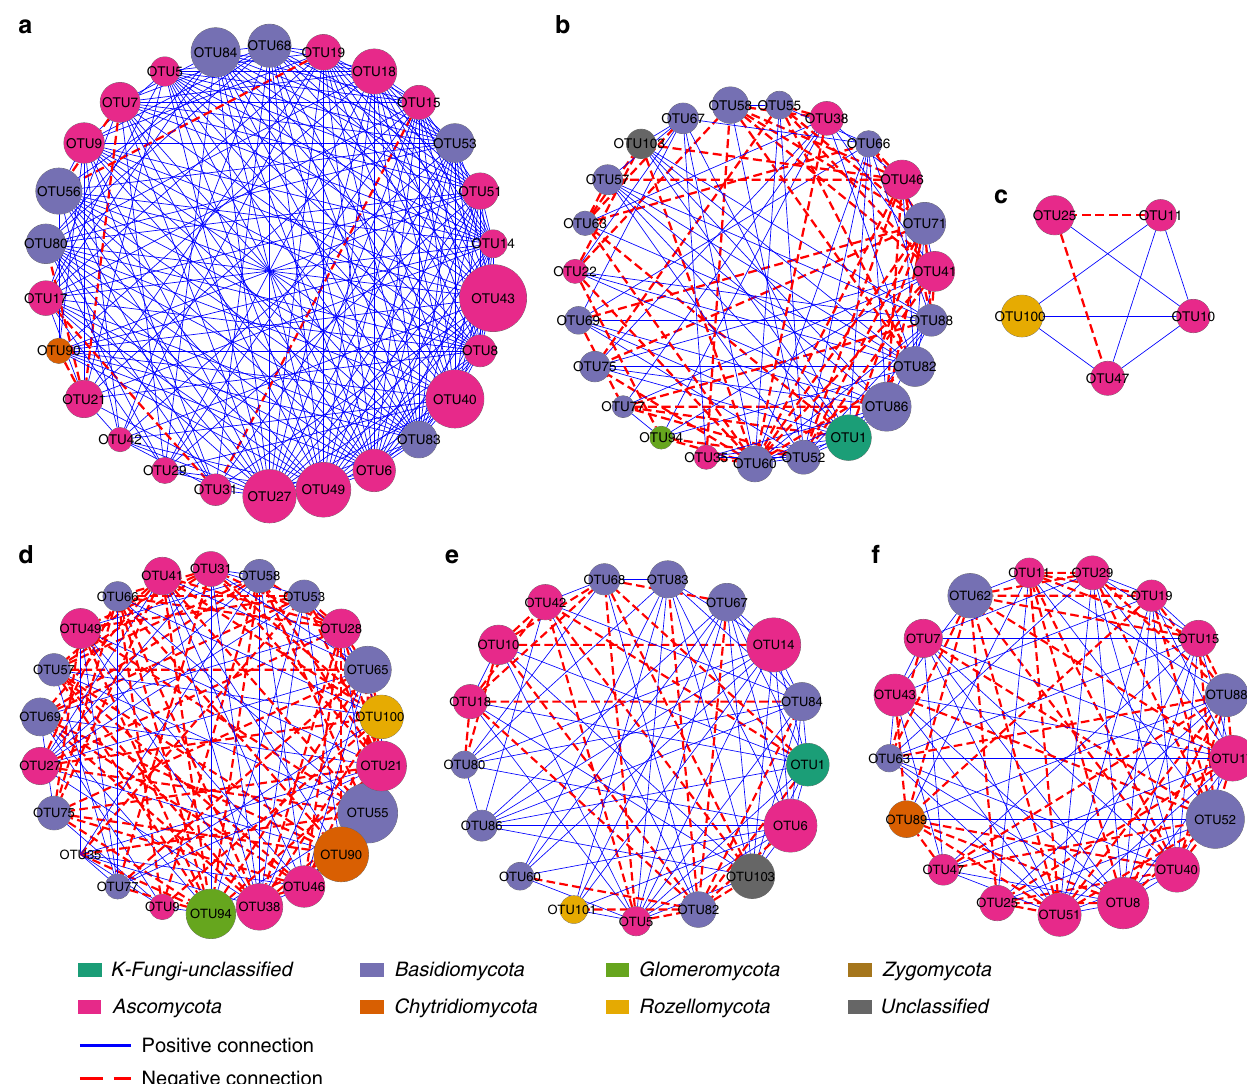
Fig. 6 Co-occurring ecological networks of fungal OTUs (order level) according to the random matrix theory. Each node represents an OTU. The connectivity between two OTUs is indicated by an edge. Blue and red edges represent positive and negative correlations, respectively. The colors of the nodes denote different phyla. The greedy modularity optimization method was used to form each of the three ecological network modules in the gold anomaly ( a – c ) and the reference ( d – f ) from fungal communities. The size of each circle indicates the degree of Stress Centrality c S (x) to each OTU in the gold anomaly and the reference area. The Stress Centrality index is used to describe the approximate amount of stress a node x has to sustain in the network by counting the number of short paths that contain node x. Thus, a node is more central when more short paths run through it. The node at the six o ’ clock position of each module has the most connections to other nodes. The degree of connection decreases counterclockwise. Detailed taxonomic annotations and the network nodes ’ centrality indexes for each OTU are shown in Supplementary Data 2 –